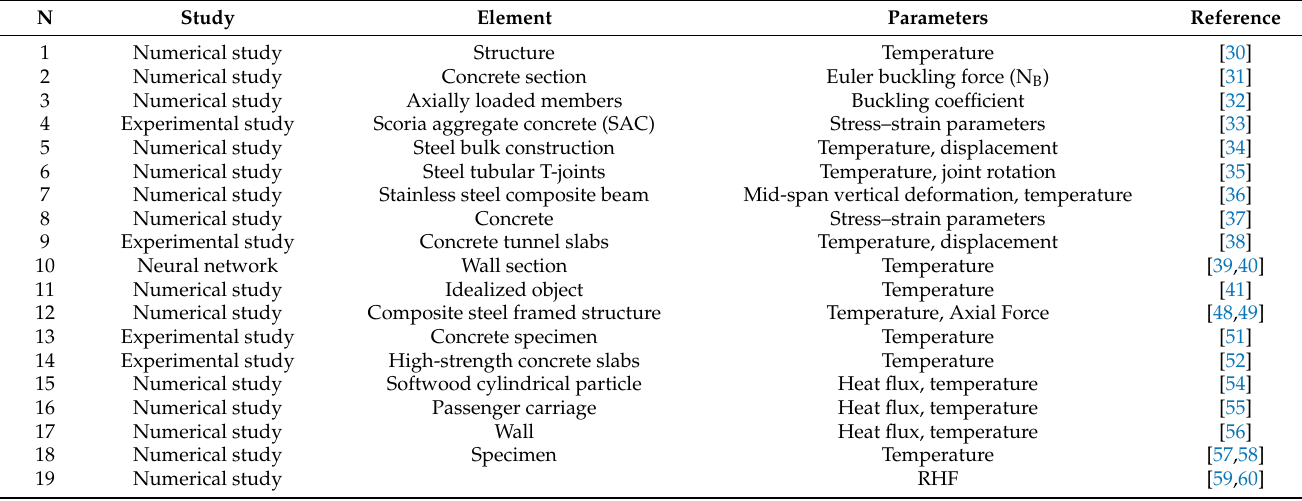
Table 2. Heat transfer in construction